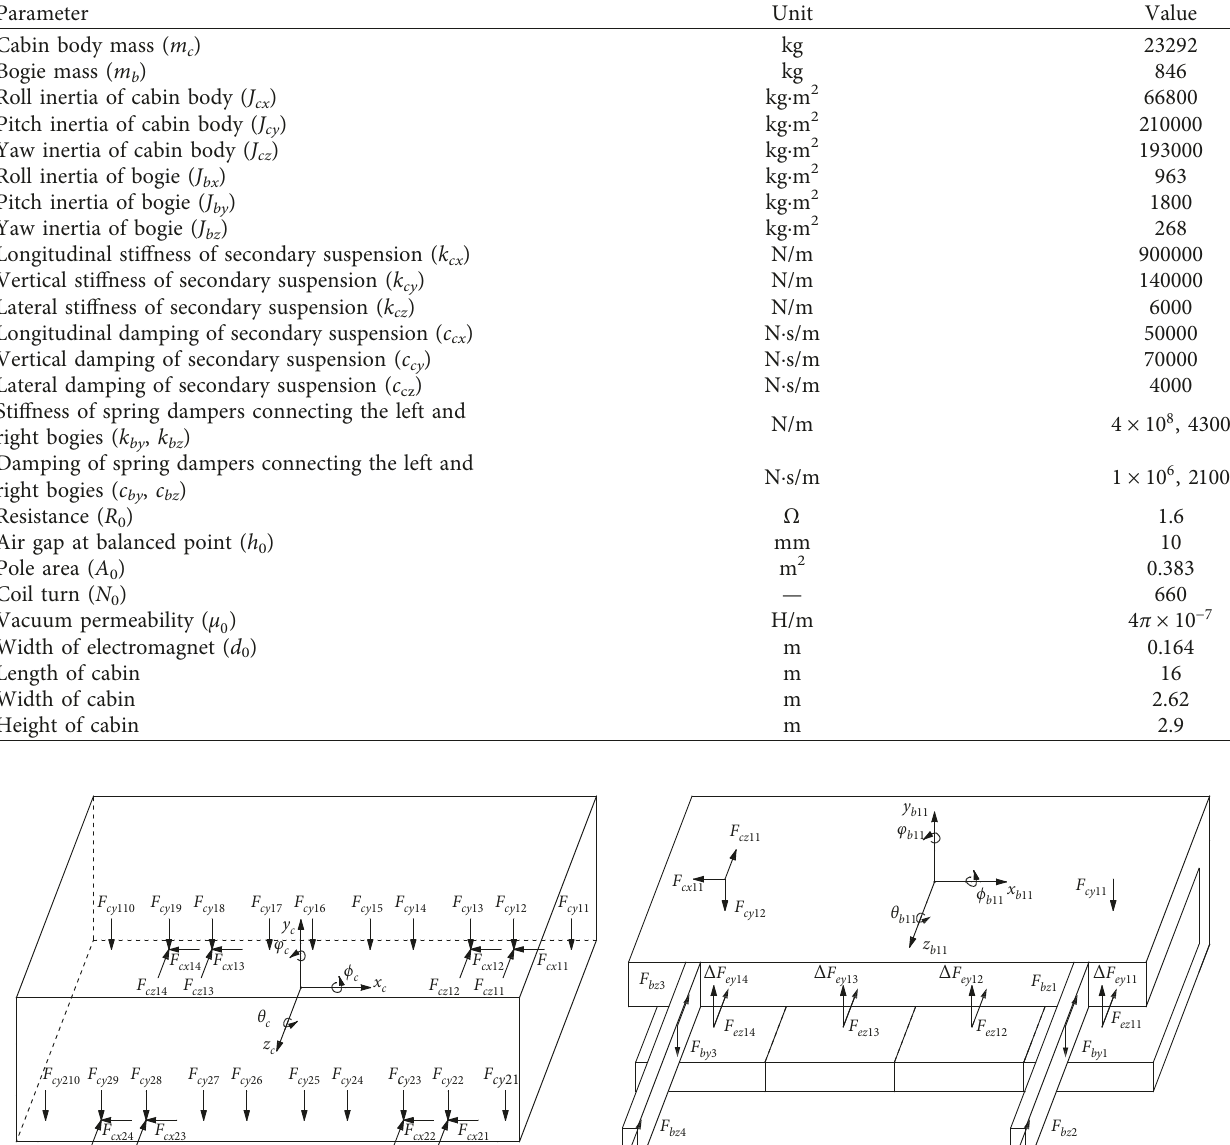
Table 1: Main parameters of the maglev vehicle.